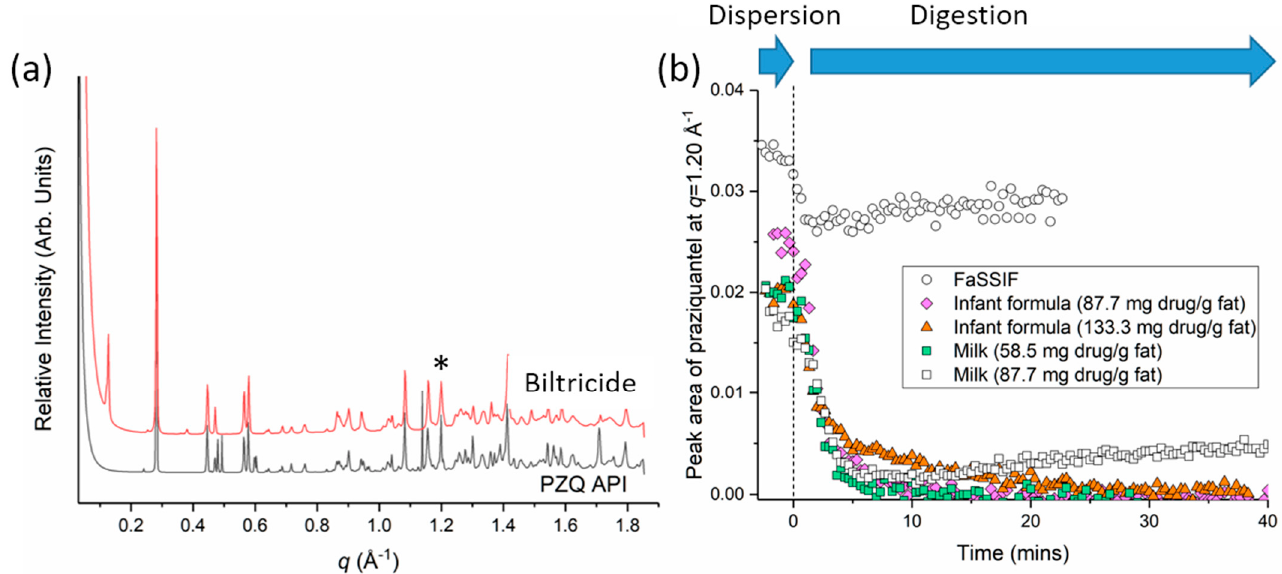
Figure 4. ( a ) X-ray scattering patterns of crushed Biltricide ® tablet and praziquantel API powder. Additional Bragg peaks in the API powder at positions q = 0.480, 0.493, 0.598, 0.603, and 1.140 Å − 1 suggest that it is a non-racemic compound [26]. ( b ) Changes in peak area during digestion for the diffraction peak at q = 1.20 Å − 1 (* in panel ( a )) in FaSSIF, milk and infant formula at different drug to fat ratios (n = 1). Pancreatic lipase was injected at 0 min to initiate digestion.